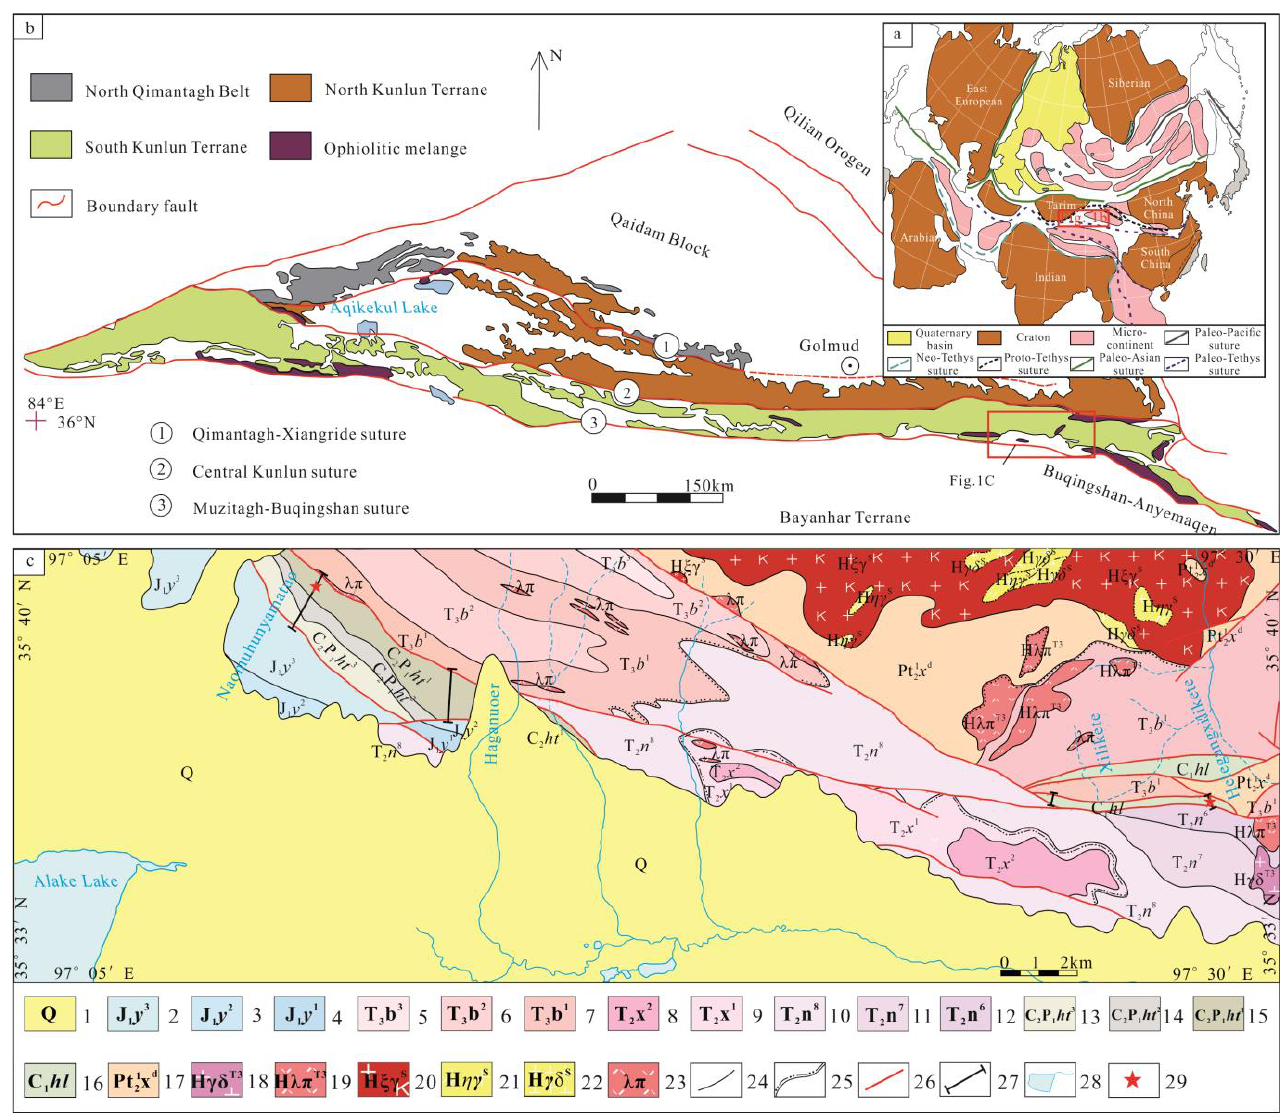
Figure 1. ( a ) Map showing the regional geological background of the EKO (modified from Zhao Guochun et al. [17]); ( b ) Simplified tectonic map showing the tectonic sub-division of EKO (modified from Dong Yunpeng et al. and Li Ruibao et al. [7,9]); ( c ) Geological map for Alake Lake area, eastern EKO. 1 — Quaternary; 2 — Upper part of Lower Jurassic Yangqu Fm; 3 — Middle part of Lower Jurassic Yangqu Fm; 4 — Lower part of Lower Jurassic Yangqu Fm; 5 — Upper part of Upper Triassic Babaoshan Fm; 6 — Middle part of Upper Triassic Babaoshan Fm; 7 — Lower part of Upper Triassic Babaoshan Fm; 8 — Upper part of Middle Triassic Xilikete Fm; 9 — Lower part of Middle Triassic Xilikete Fm; 10 — Part 8 of Middle Triassic Naocangjiangou Fm; 11 — Part 7 of Middle Triassic Naocangjiangou Fm; 12 — Part 6 of Middle Triassic Naocangjiangou Fm; 13 — Upper part of Upper Carboniferous to Lower Permian Haoteluowa Fm; 14 — Middle part of Upper Carboniferous to Lower Permian Haoteluowa Fm; 15 — Lower part of Upper Carboniferous to Lower Permian Haoteluowa Fm; 16 — Lower Carboniferous Halaguole Fm; 17 — part d of Middle Proterozoic Xiaomiao Fm; 18 — Late Triassic biotite granodiorite; 19 — Late Triassic rhyolite; 20 — Silurian K – feldspar granite; 21 — Silurian monzogranite; 22 — Silurian granodiorite; 23 — rhyolitic dyke; 24 — geological boundary; 25 — angular unconformity; 26 — fault; 27 — measured profile location; 28 — Lake and river; 29—sample locations for zircon U–Pb